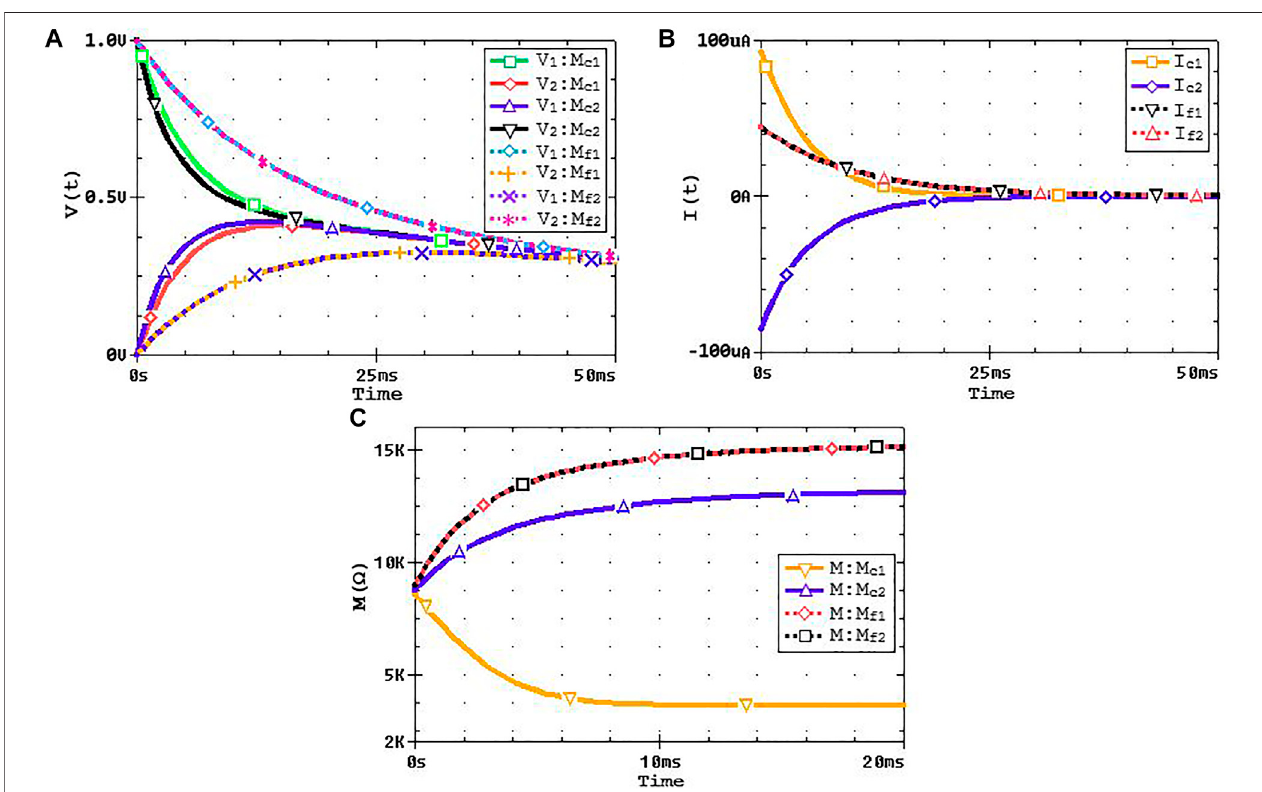
FIGURE 13 | Comparing the system evolution using the circuit of Figure 5 by considering memristor (M) and then memristor fuse (M f ). Mc1 and Mc2 correspond, respectively, to a single memristor used according to Cond-1 and Cond-2, while Mf1 and Mf2 correspond, respectively, to a memristor fuse used according to Cond-1 and Cond-2. The results show the response for each case until the system stabilized: (A) the voltage evolution as V 1 ( t ) and V 2 ( t ) , (B) the fl owing currents through the memristor (I e1 and I e2 for Cond-1 and Cond-2, respectively) and memristor fuse (I f1 and I f2 for Cond-1 and Cond-2, respectively), and (C) memristance transition. Given the same initial condition, the results show that the memristor fuse conducts equally in both directions. For Mc1, Mc2, Mf1, and Mf2, c1, c2, f1, and f2 are subscripts denoting Cond-1 and Cond-2,